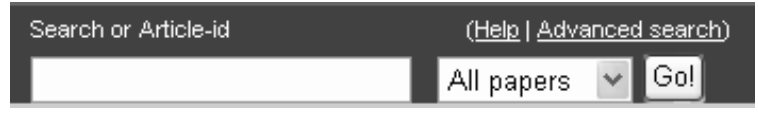
Figure 1. Arxiv search interface: a simple search form.